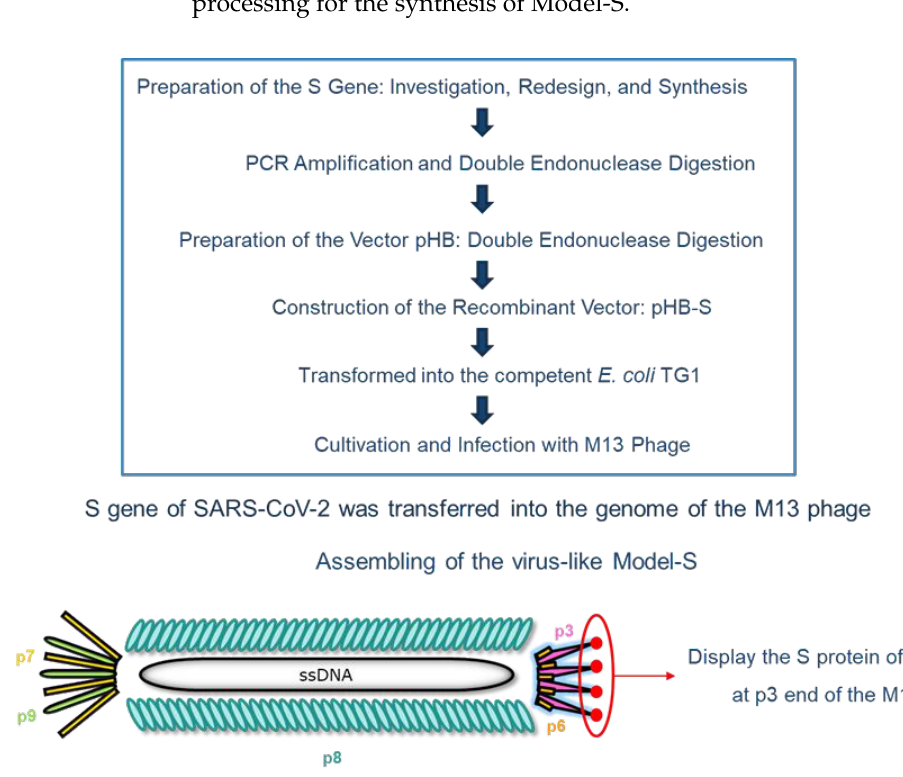
Figure 6. Schematic flow diagram for the preparation of the virus-like Model-S. After searching the gene corresponding to the S protein of SARS-CoV-2 at the National Center for Biotechnology Information (NCBI) website (Gene ID: 43740568), it was modified by adding Sfi I and Not I restriction digest sites on both sides. After the regular PCR amplification and double endonuclease digestion by Sfi I/ Not I enzyme, the inserted